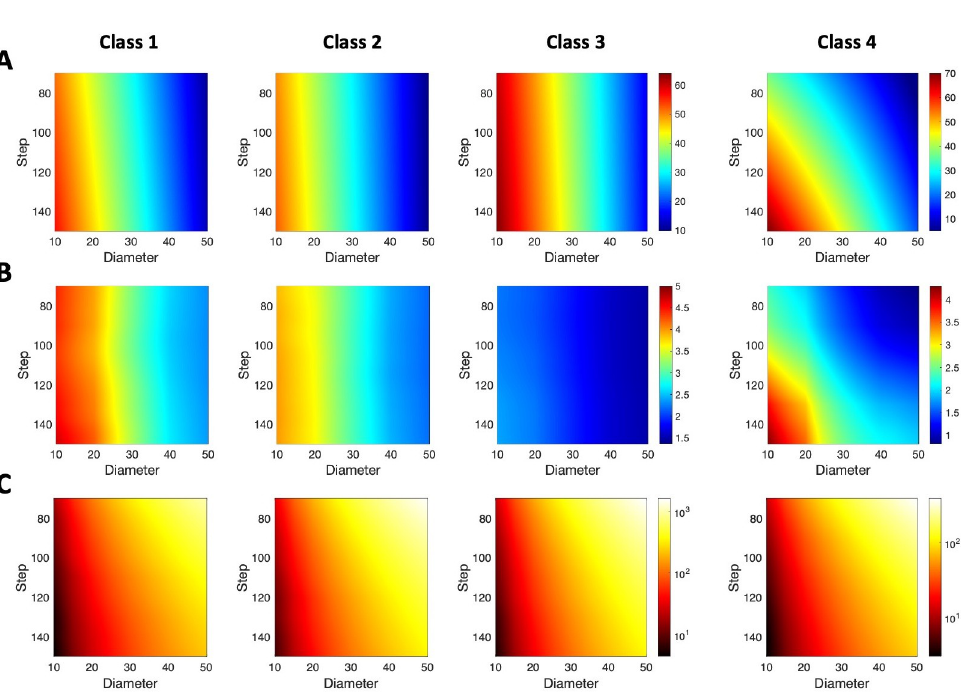
Fig 6. Mean absolute error for axon length estimation by spheres-based stereology. A . The mean absolute error (in % of the real axon length indicated by colors–see color bar) is shown for different values of the probe diameters and the step between sampling boxes, and for axon classes 1 to 4 (columns). Note that the color bar is the same for classes 1, 2, and 3. B. Accuracy of the mean error estimation as maximum error estimation at 95% confidence (in % of the real axon length indicated by colors; same color bar for classes 1, 2, and 3). C . Mean effort, quantized by the mean number of intersections, required to estimate the axon length with different values of the probe diameter and the step for axon classes 1 to 4. Colors denote the number of intersections (in logarithmic scale; same color bar for classes 1, 2, and 3). Mean intersection values were obtained through linear interpolation from estimation for diameter values in 10, 15, 20, ... ,50 μ m and step values in 70, 80, ... ,150 μ